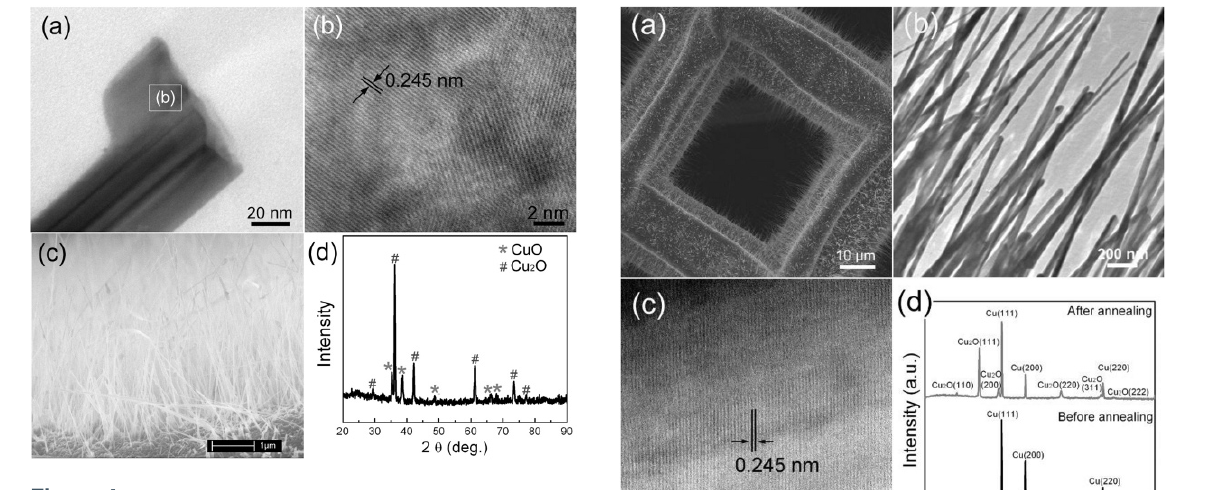
Figure 4. The TEM image of a nanowire root (a) and HRTEM image of the root. The SEM image and XRD pattern of nanowires produced by annealing Cu foil at 500°C.